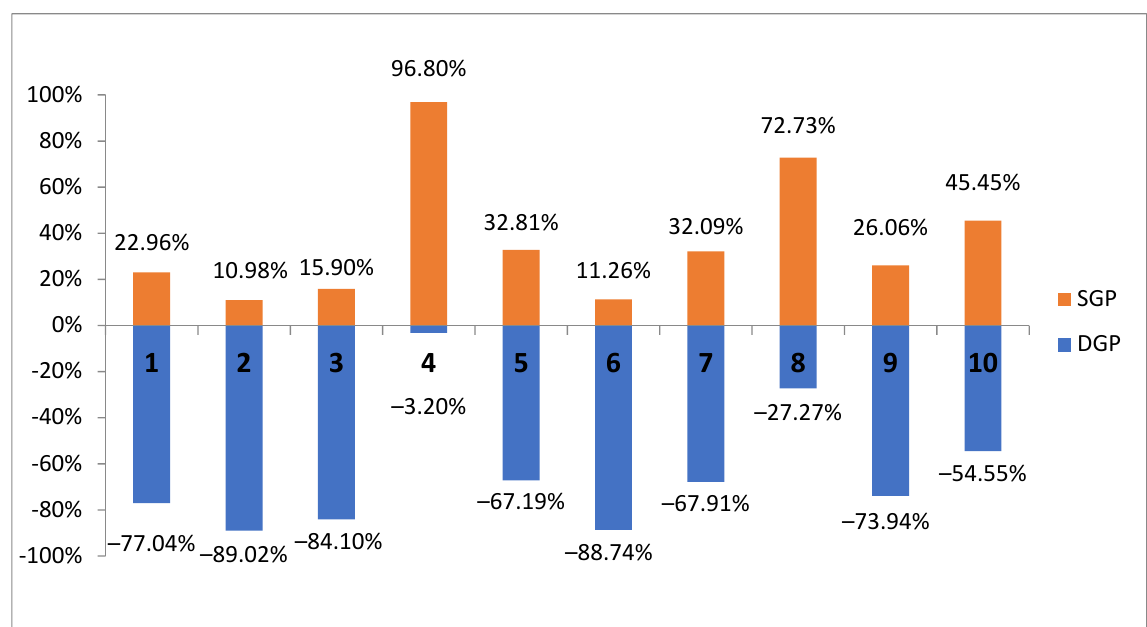
Figure 2. Satisfaction- and dissatisfaction-generating potentials of event attributes. Numbers 1–10 on the bar charts refer to the attributes as stated in Tables 2 and 3.